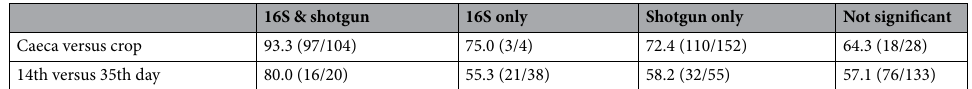
Table 1. Percentage of genera having a concordant change in abundance in shotgun and 16S samples with a statistically significant change for: both sequencing strategies (1st column), 16S only (2nd column), Shotgun only (3rd column), neither (4th